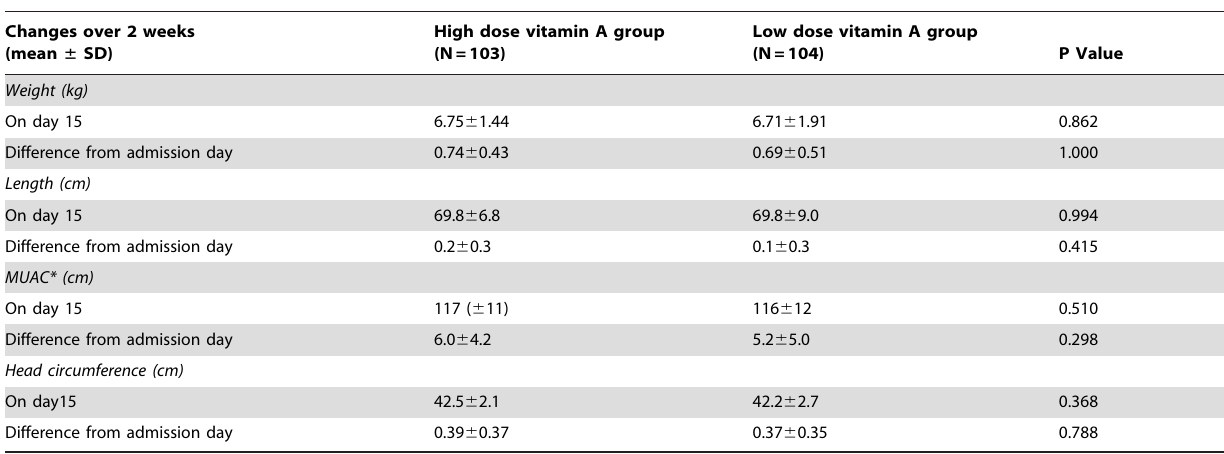
Table 4. Change in nutritional status by treatment group.